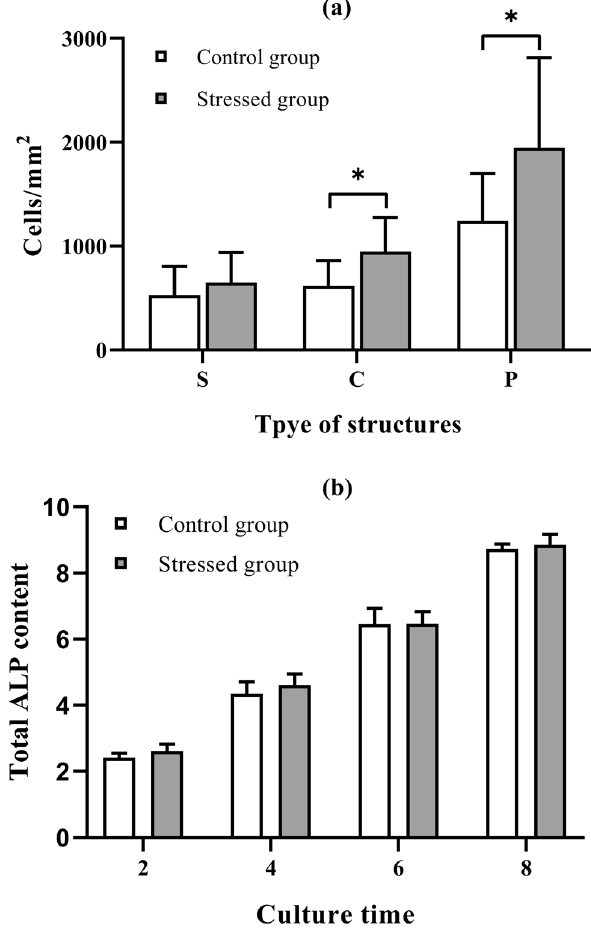
Figure 5: Results of experimental data analysis: ( a ) average cell density on each typical structure in the stressed and control groups; ( b ) total ALP content in the stressed and control groups on di ff erent days. * p <